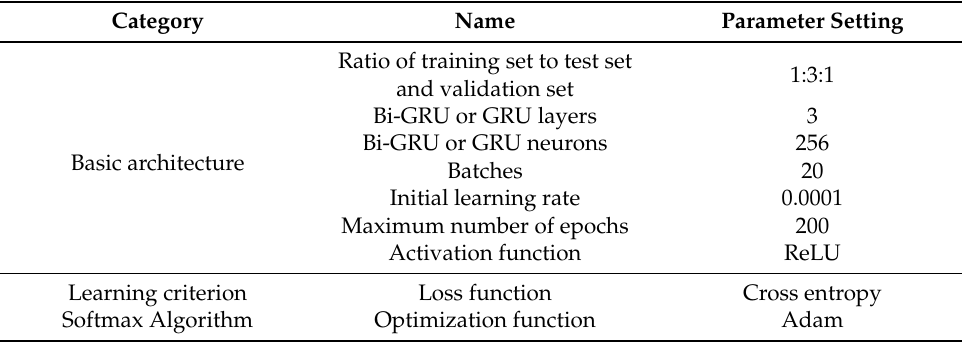
Table 8. The parameters and hyperparameters of Bi-GRU and